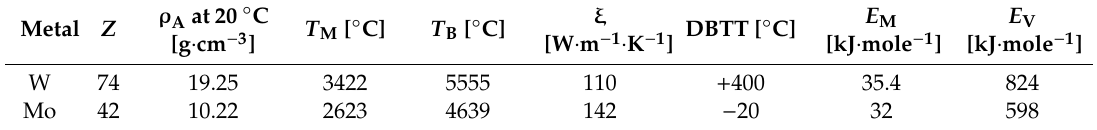
Table 1. A comparison of some physical properties of W and Mo: atomic number Z , density ρ A ,